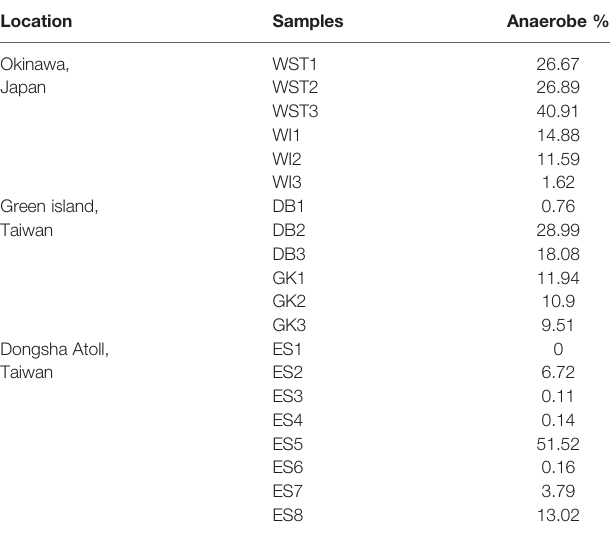
TABLE 3 | Percentage of anaerobes in each